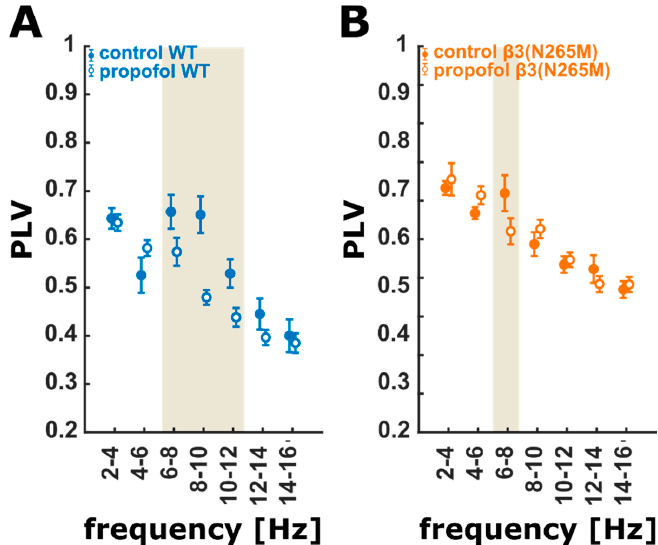
Figure 2. PLV for the wild-type ( A ) and β 3(N265M) mutant recordings ( B ) for non-overlapping 2 Hz